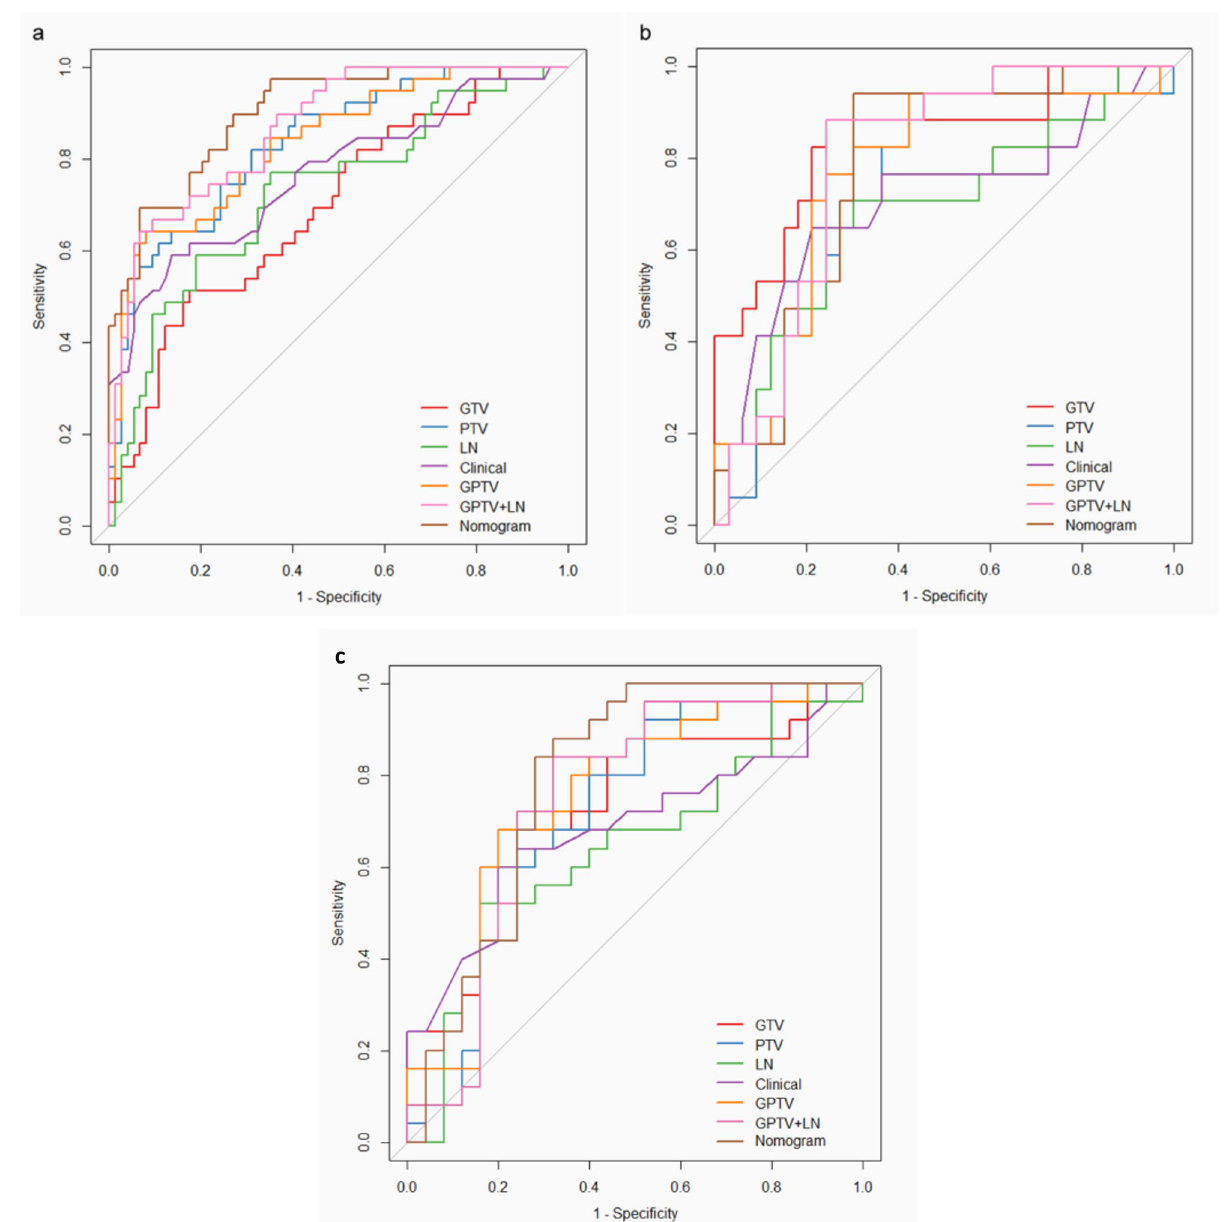
Figure 3. The receiver operating characteristic (ROC) curves of radiomic signatures: ( a ) training cohort, ( b ) internal validation cohort ( c ) external